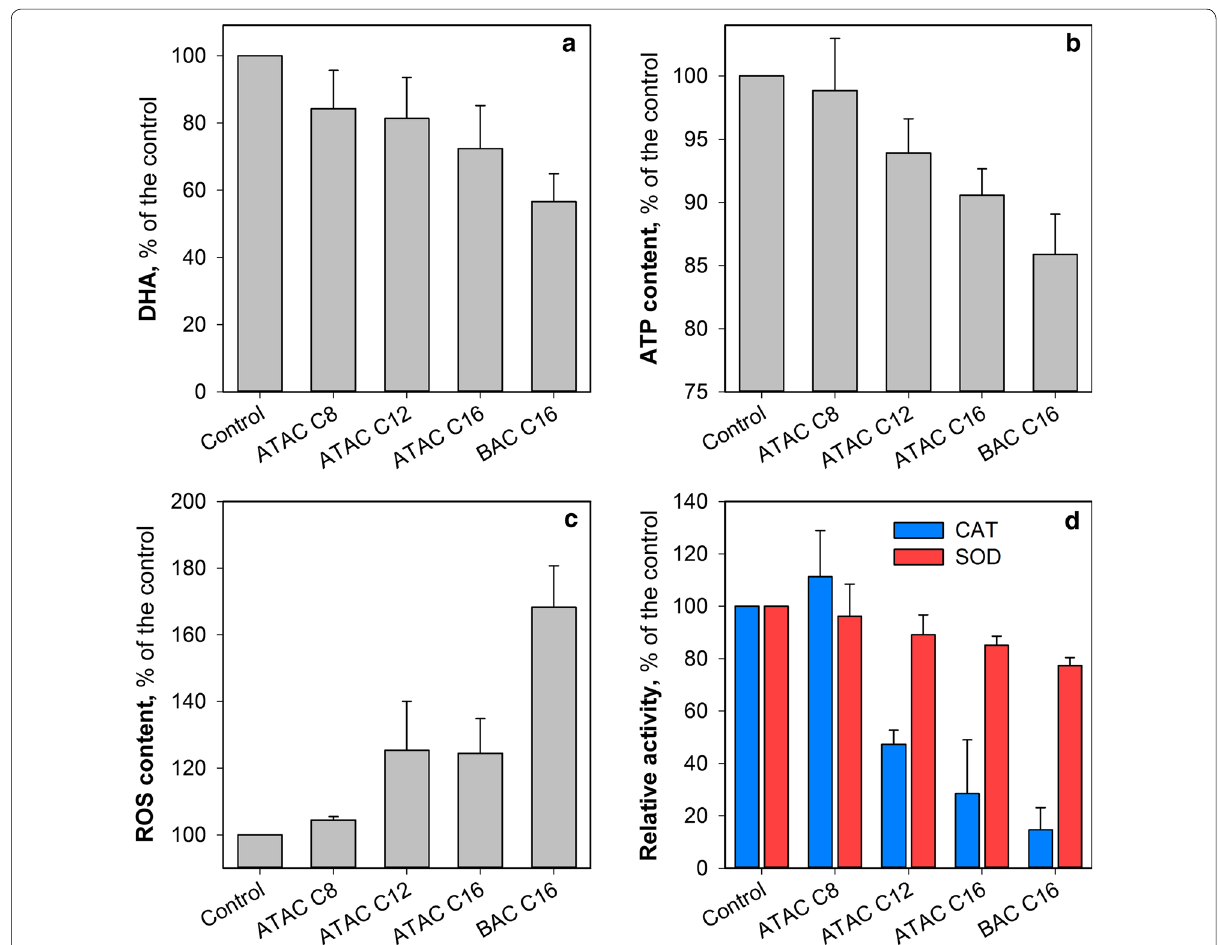
Fig. 3 Variations of a DHA, b ATP content, c ROS content and d CAT and SOD activities of the sludge samples following 2-h exposure to QACs. Tests were conducted at least in